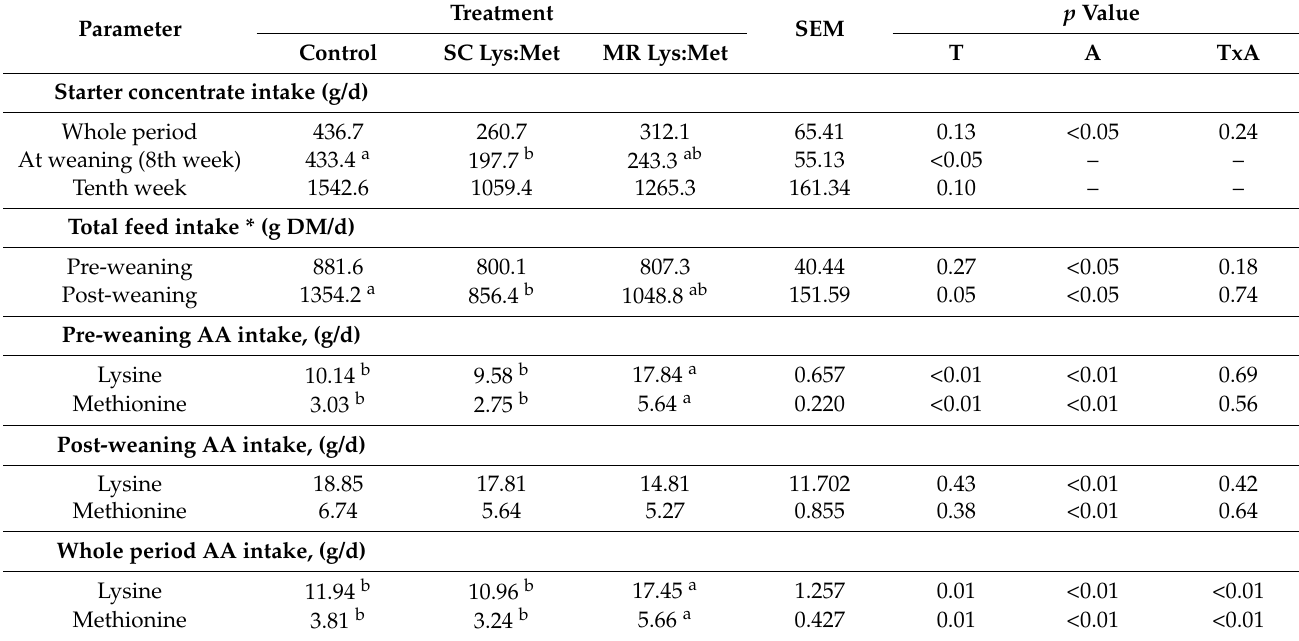
Table 2. Intake of starter, total feed, lysine and methionine of dairy calves with or without lysine and methionine supplementation in starter or in milk replacer.